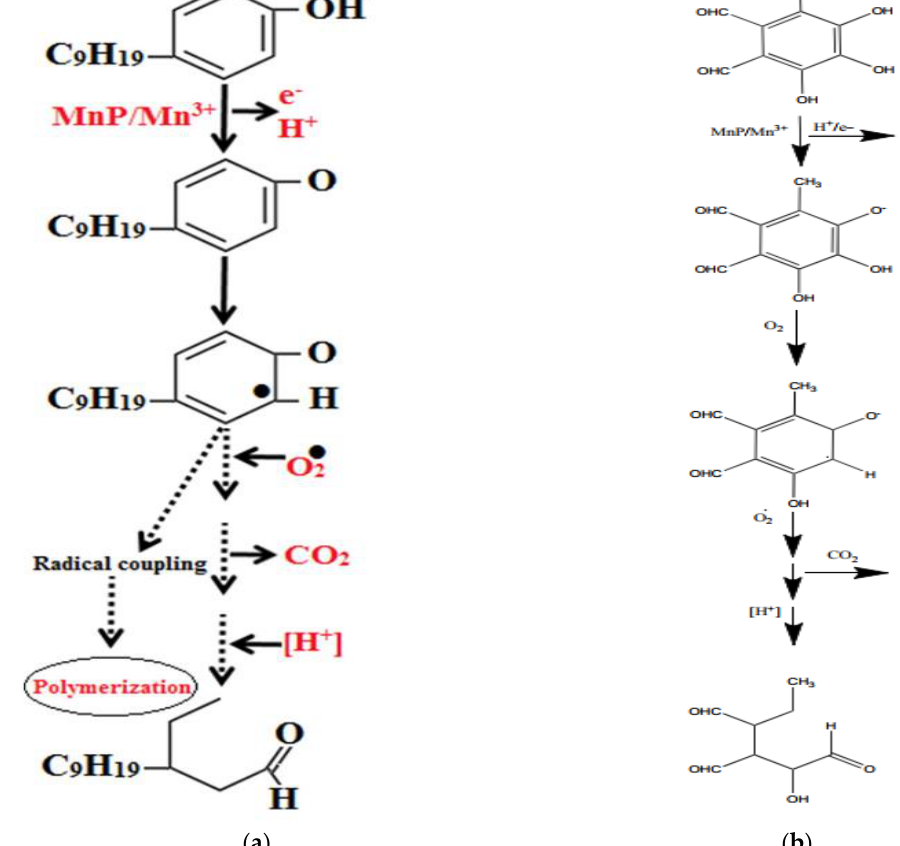
Figure 8. ( a ) Hypothetical degradation of phenolic compounds ( b ) Hypothetical degradation of fungal pigment flavipin.